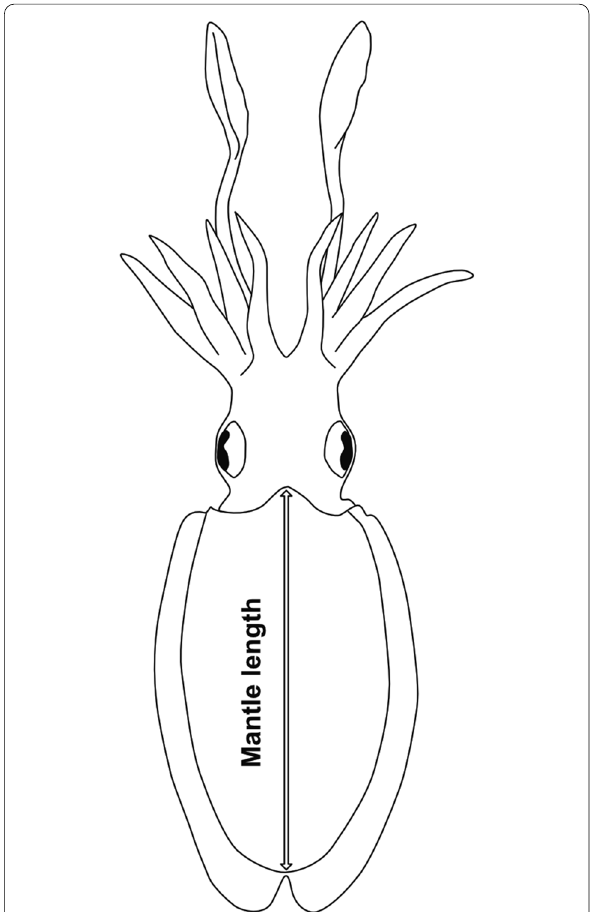
Fig. 1 Dorsal view of a cuttlefish showing standard dorsal mantle length measurement